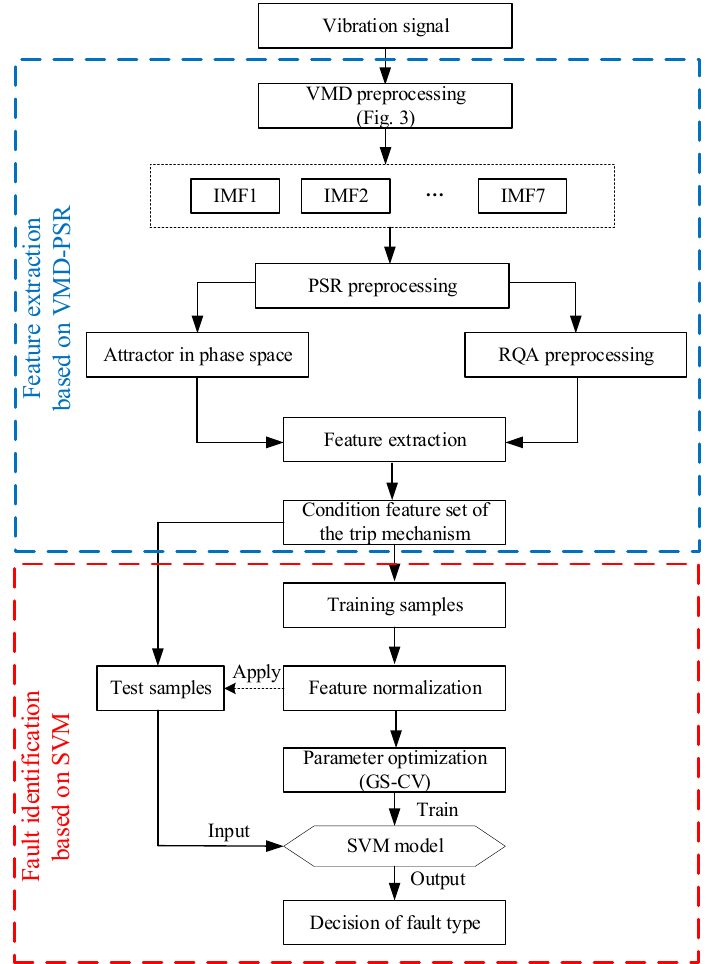
Figure 9. The fault identification process based on VMD ‐ PSR and SVM.